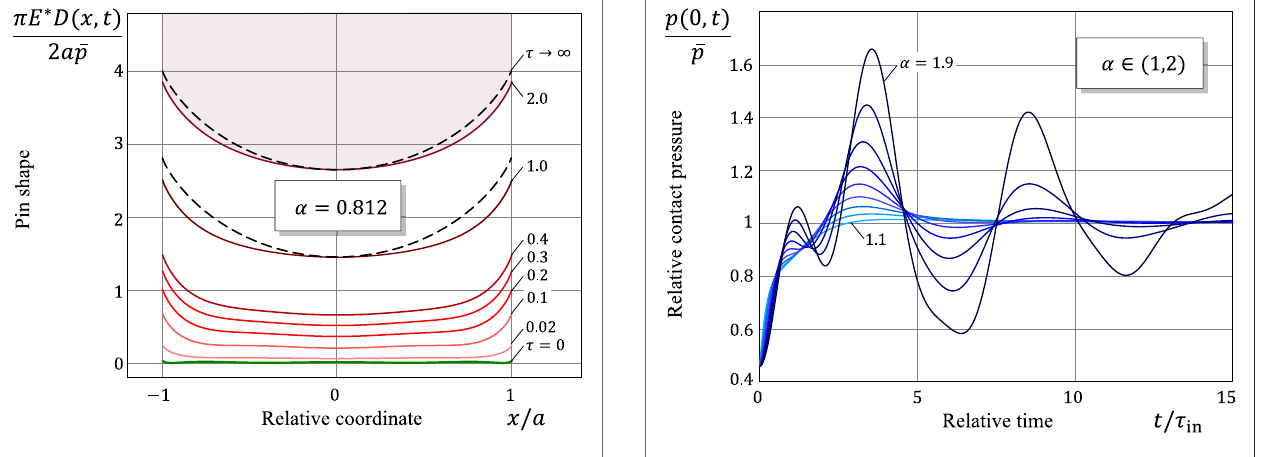
FIGURE 12 | Pin shape at different values of the relative time variable τ = t / τ in inthesub-Archardwearcase.Thedashedlinescorrespondtothelimiting pro fi le.